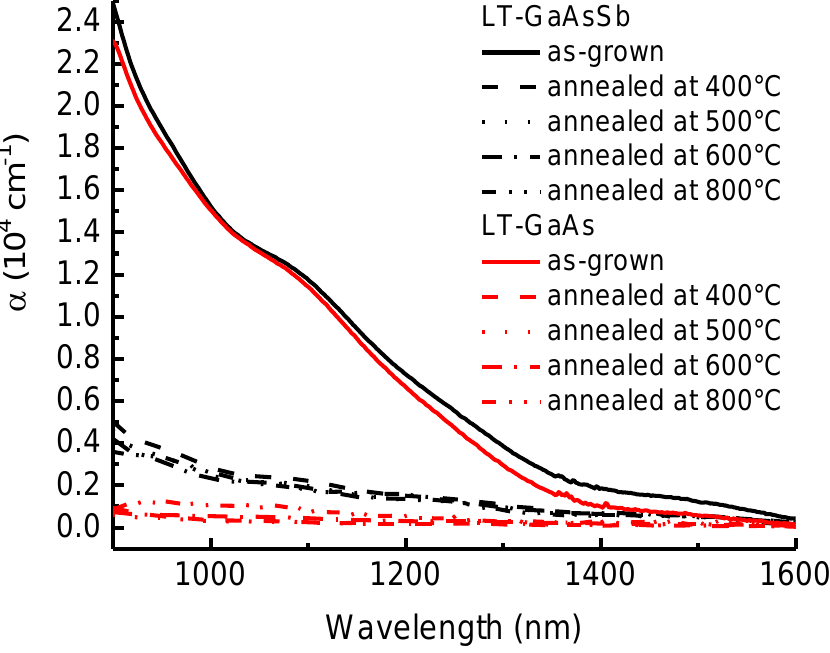
Figure 6. Spectra of the optical extinction coefficient for the LT-GaAs and LT-GaAs 0.97 Sb 0.03 samples before and after annealing at different